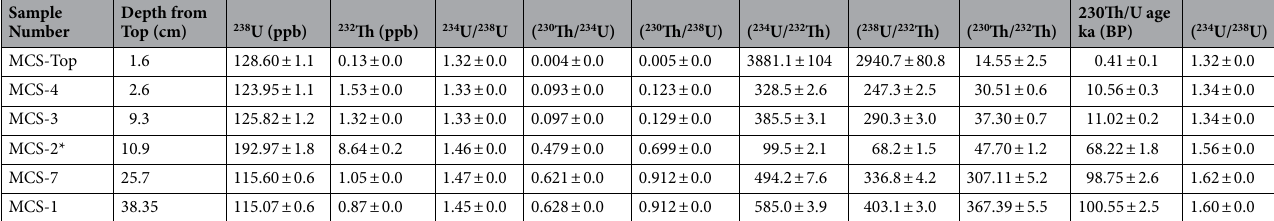
Table 1. U/Th dating results from the Radiochronology laboratory of the GEOTOP-UQAM-McGill Research Center. *Refers to dating results that were not used in the age model. B.P. stands for “Before Present” where the “Present” is defined as the year 1950 A.D.